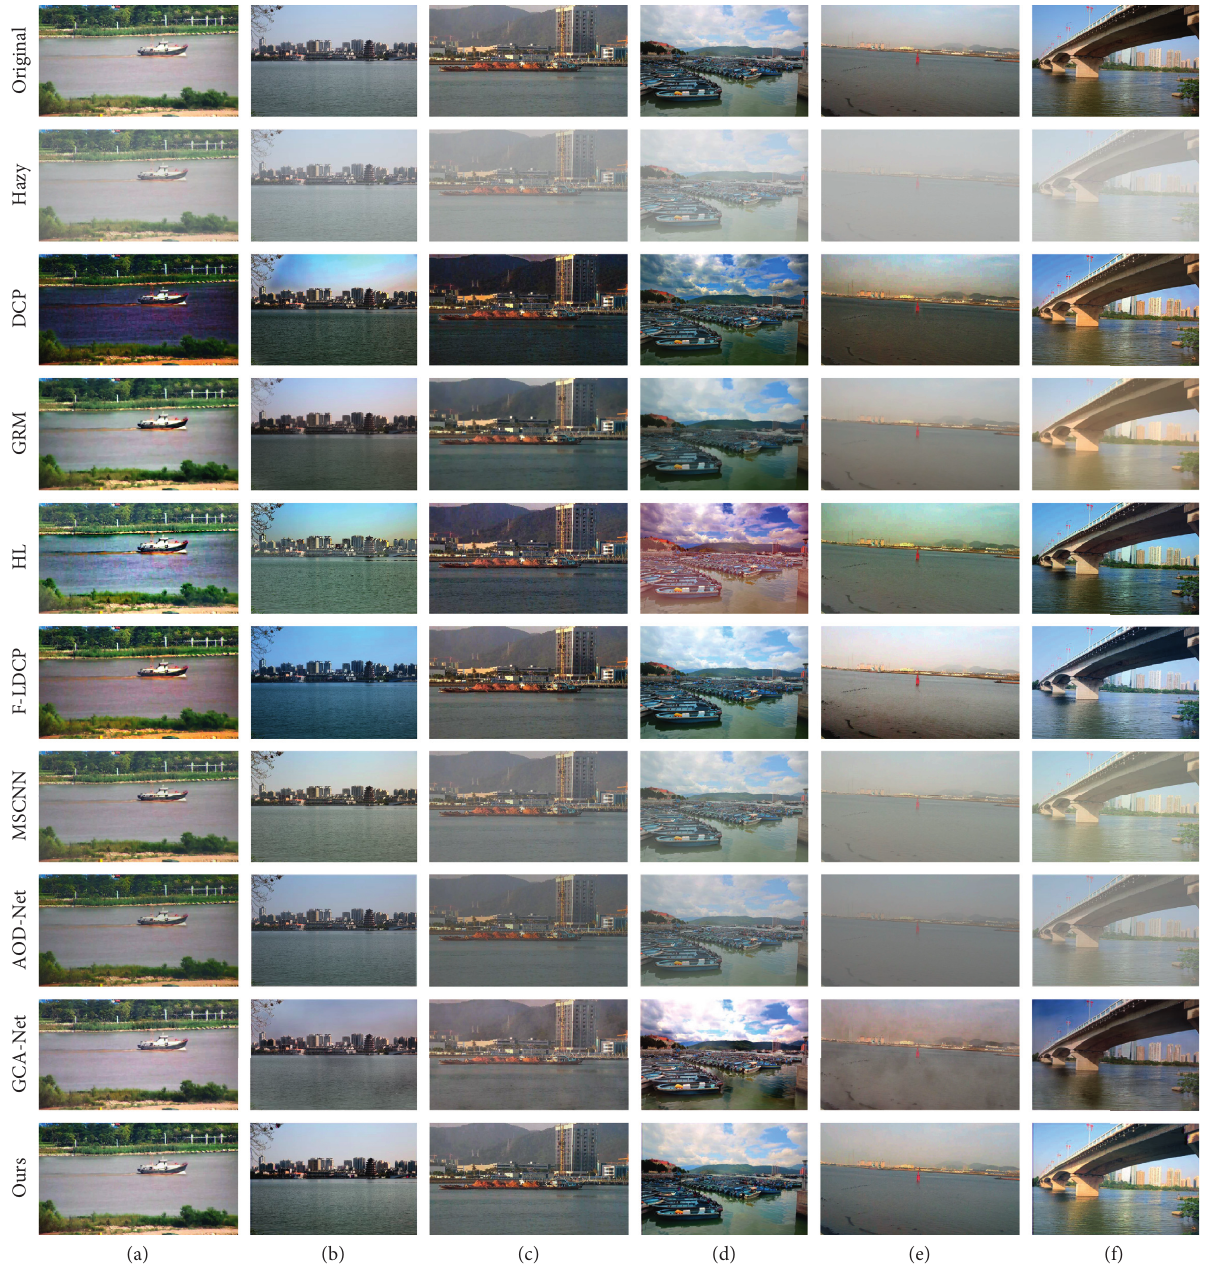
Figure 6: Comparisons of synthetic experiments on six typical hazy images in Figure 5. Each column represents the hazy image synthesized by different combinations of A and t , the original image corresponding to the hazy image, and the dehazing results obtained by all ∞ � 0 . 8/ t � 0 . 6, (b) hazy Image 2 with A � 0 . 9/ t � 0 . 6, (c) hazy methods. From left to right in the second line: (a) hazy Image 1 with A ∞ ∞ � 0 . 8/ t � 0 . 4, (d) hazy Image 4 with A � 0 . 9/ t � 0 . 4, (e) hazy Image 5 with A � 0 . 8/ t � 0 . 2, and (f) hazy Image 6 with Image 3 with A ∞ ∞ ∞ A � 0 . 9/ t � 0 . 2, ∞